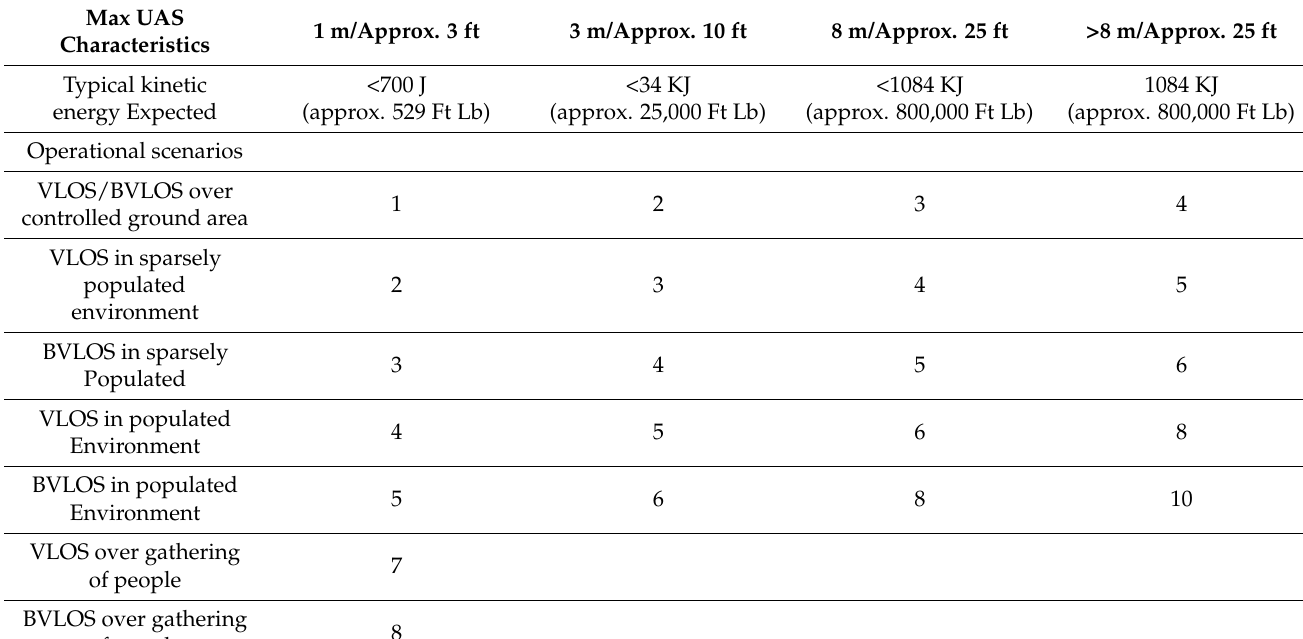
Table 4. Intrinsic ground risk (GRC) determination